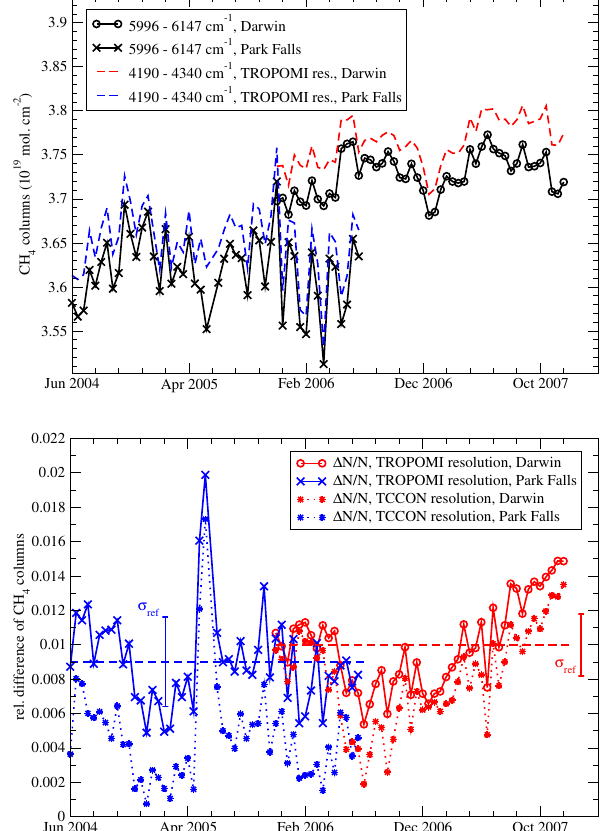
Fig. 3. CH 4 retrieval accuracy for the 4190–4340cm − 1 range. The upper panel shows the time-series of CH 4 columns at Park Falls (crosses) and at Darwin (circles). The lower panel shows the rela- tive differences between columns retrieved at original (dotted lines) and at TROPOMI resolution (solid lines) with respect to reference values from 5996–6145cm − 1